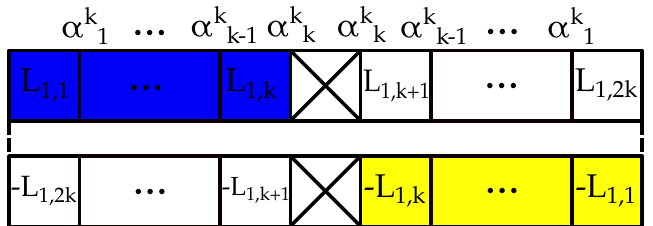
Figure 10. The (cid:13)avor-equivalence classes associated to E 7 with N f 56 , where N f is a half-integer, involve the (cid:13)avor-equivalence classes of E 7 (cid:2) SO(2 N f ) with matter in the ( 56 ; 2 N f ). The (cid:13)avor- equivalence classes depend only on the weights written here, and the sign associated to some of them is (cid:12)xed, as shown. The boxes marked with crosses correspond to the weights that are zero-weights under the 2 N F representation, which cannot be consistently assigned a